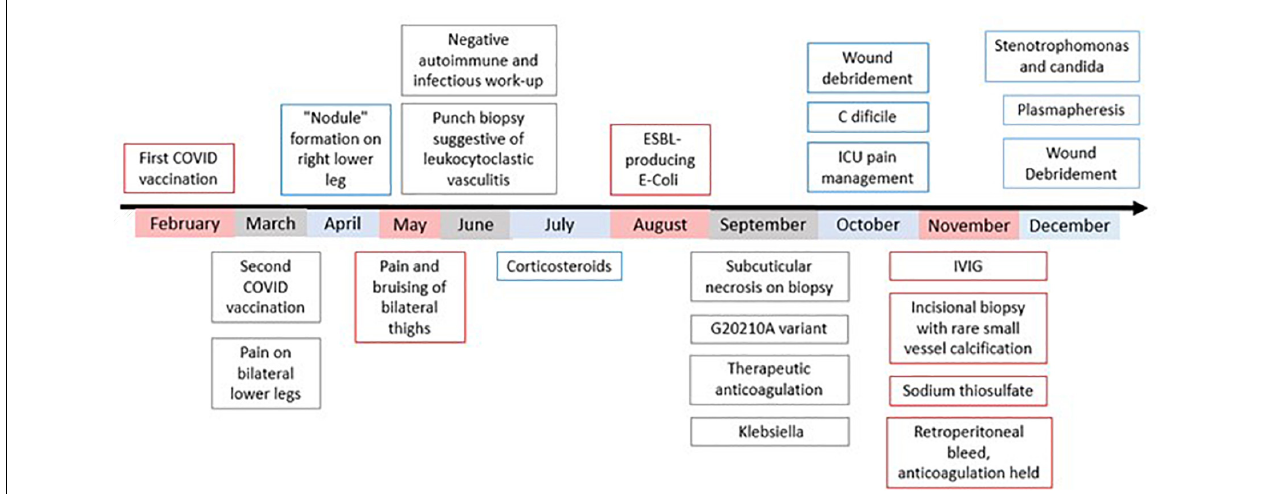
FIGURE 1 | Chronological depiction from patient’s initial presentation to current working diagnosis. Work-up prior to September was performed at outside institutions. In September, the patient was admitted to our institution for treatment. At no point during this course have lesions stopped progressing. In early February, the patient unfortunately passed away.